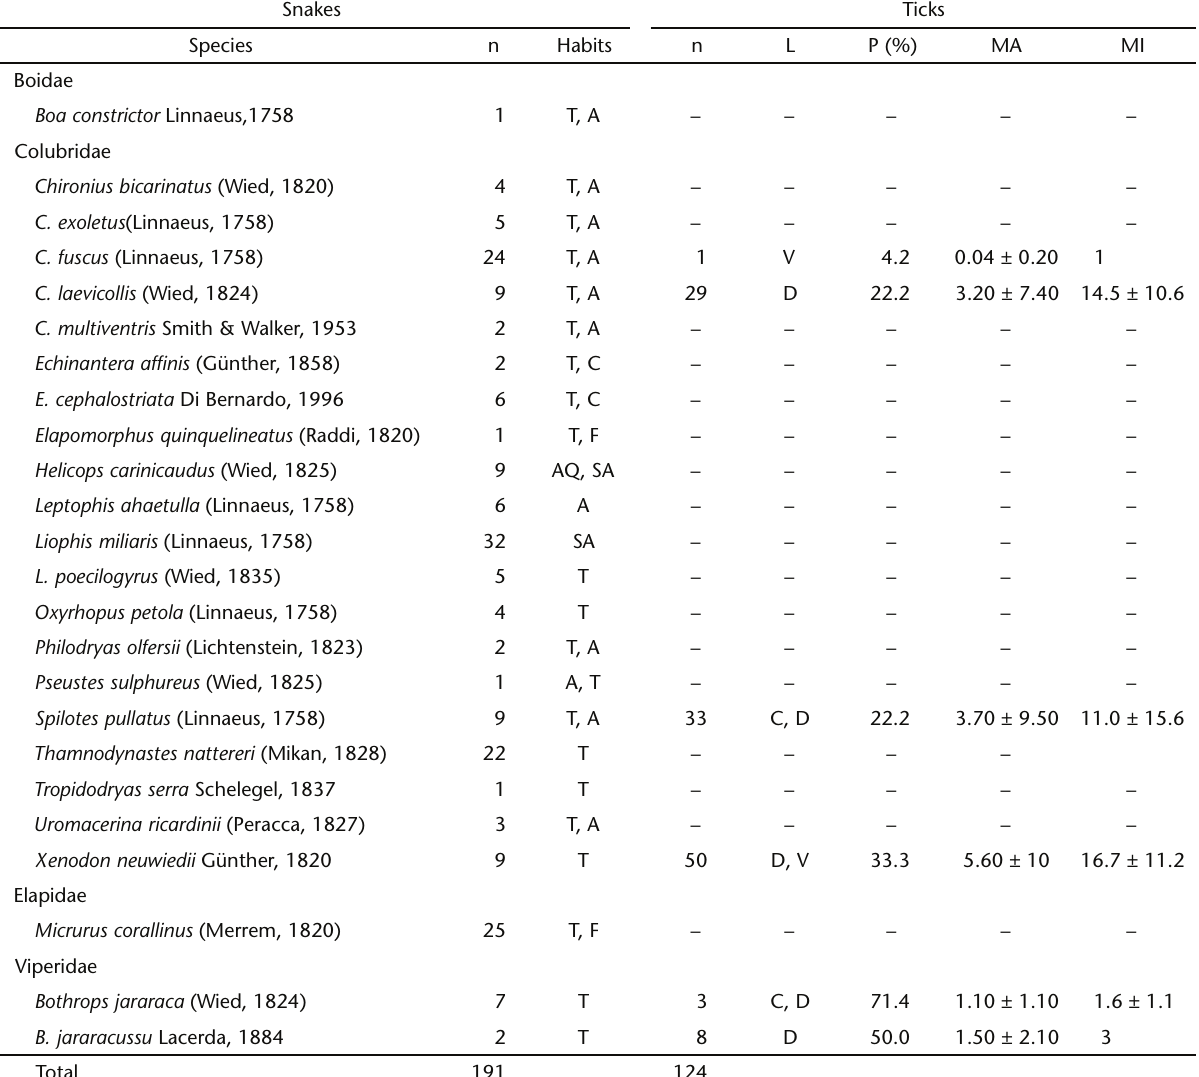
Table I. Species of snakes sampled from the Atlantic Forest, Serra do Medanha (n = 191), Rio de Janeiro, including their habits: (A) arboreal, (AQ) aquatic, (C) cryptozoic, (F) fossorial, (SA) semi-aquatic, (T) terrestrial; including location on the body of the host (L): (C) cephalic region, (D) dorsal region, (V) ventral region; and parameters of parasitism: (P) prevalence, (MA) mean abundance, (MI) mean intensity. Snakes Ticks